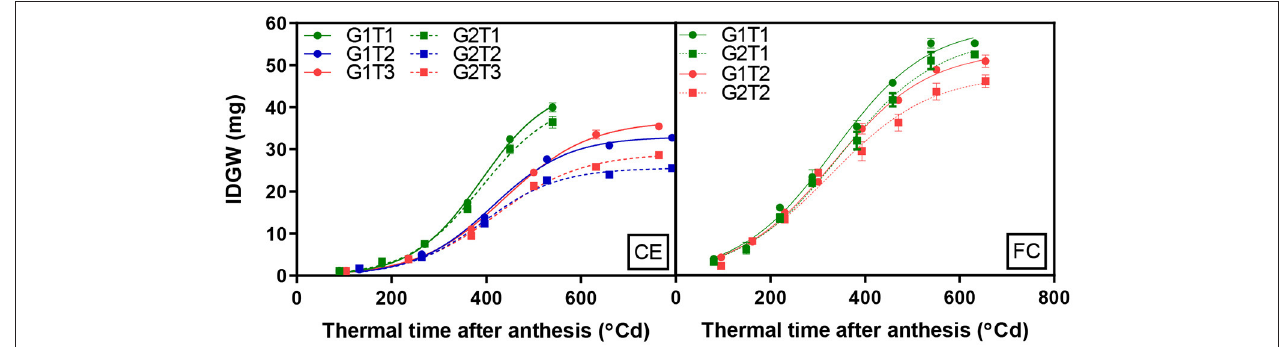
FIGURE 2 | Change in individual grain dry weight (IGDW) of grains from spikelets 8, 9, and 10 on the main spike over time for two wheat genotypes (G1, putative heat tolerant, circles and solid lines; G2, putative heat susceptible, squares and dotted lines) in response to day/night temperatures of CET1 [control (22/14 ◦ C)], CET2 (30/20 ◦ C from heading), and CET3 (30/20 ◦ C from anthesis) under controlled environment conditions (CE) or heat chambers in the field (FC) (FCT1, ambient temperature chamber and FCT2, heated chamber) on IGDW. Error bars represent SEM, n = 4.